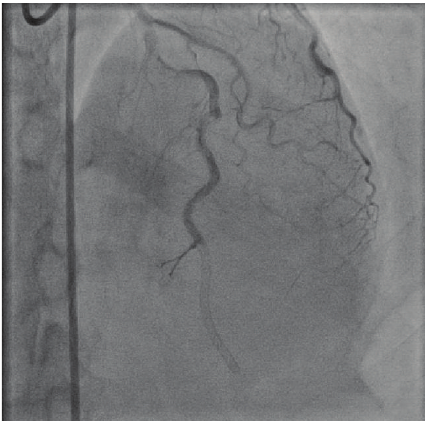
Figure 5: After second intervention cardiac catheterization showed distal LAD stent thrombosis with TIMI Grade 0 flow.